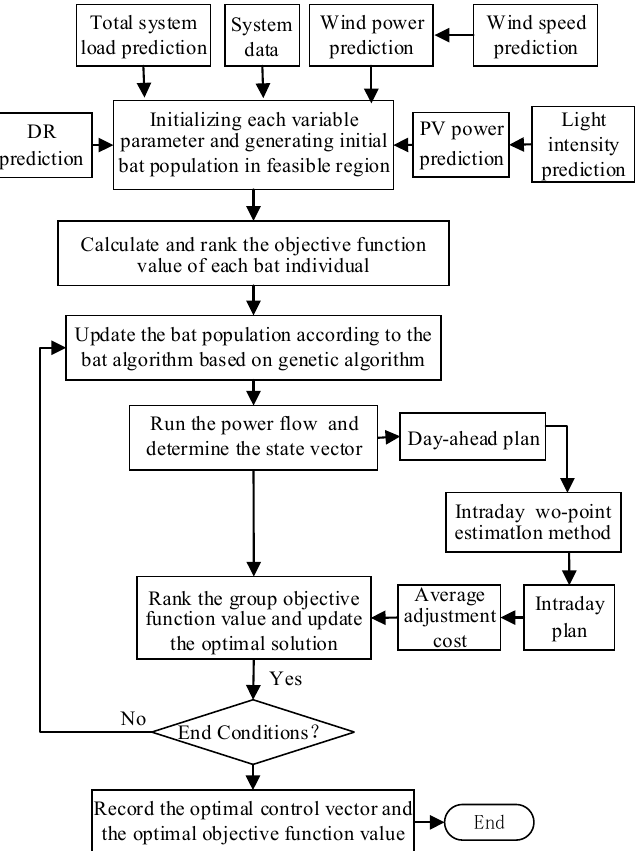
Figure 3. Two-stage optimal scheduling solution flow chart.